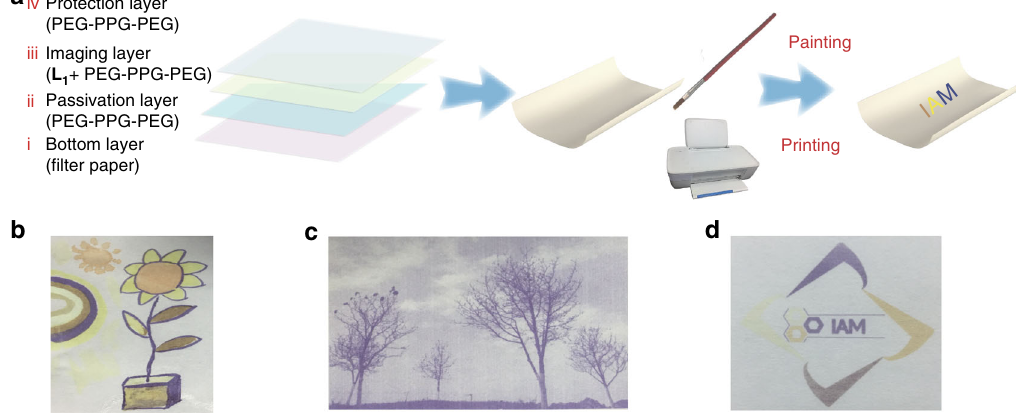
Fig. 3 Structure and multicolour printing of rewritable paper. a Schematic illustrations of four-layer structure used to create the rewritable paper based on L 1 . b Colourful image of a fl ower drawn by different metal salts aqueous solution as ink. Scale bar = 1 cm. c An image of trees printed using a customized black inkjet cartridge fi lled with FeCl 2 aqueous solution. Scale bar = 1 cm. d Colourful printing of the badge of Institute of Advanced Materials using an inkjet cartridge fi lled with FeCl 2 , Zn(NO 3 ) 2 and Co(NO 3 ) 2 , respectively. Scale bar = 1